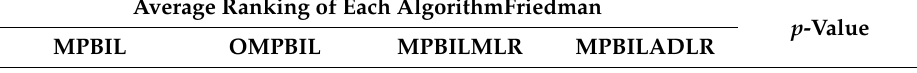
Table 2. Average ranking and p -value of MPBIL, and enhanced performance of MPBIL achieved by Friedman test.